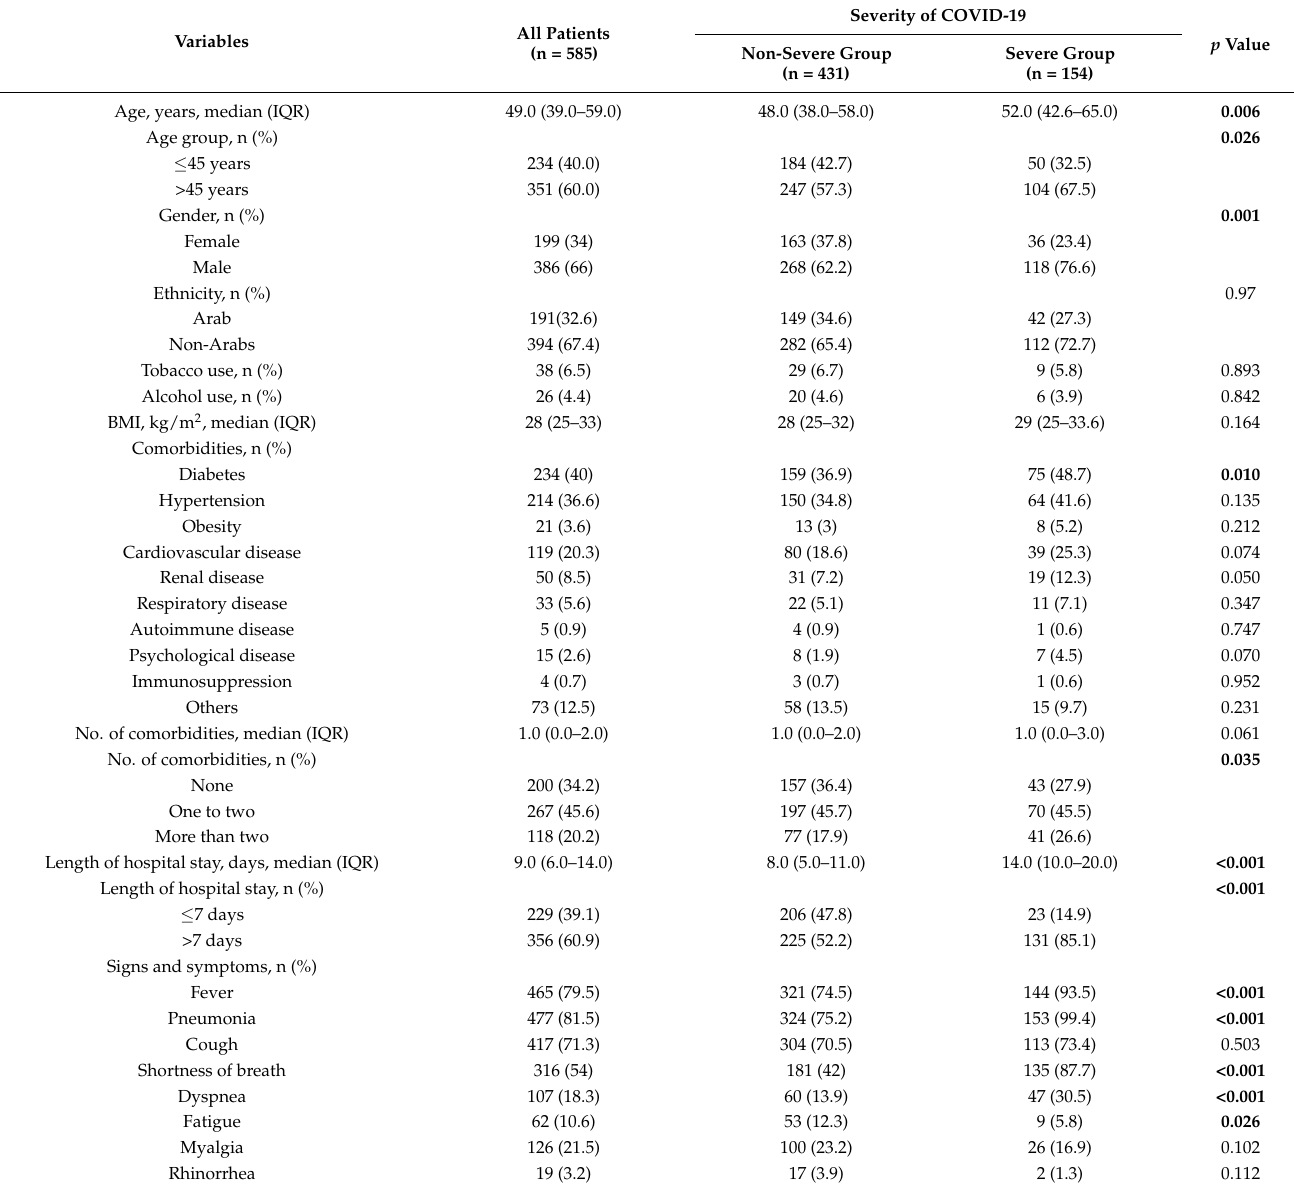
Table 1. Demographic and clinical characteristics of COVID-19 patients stratified by severity of